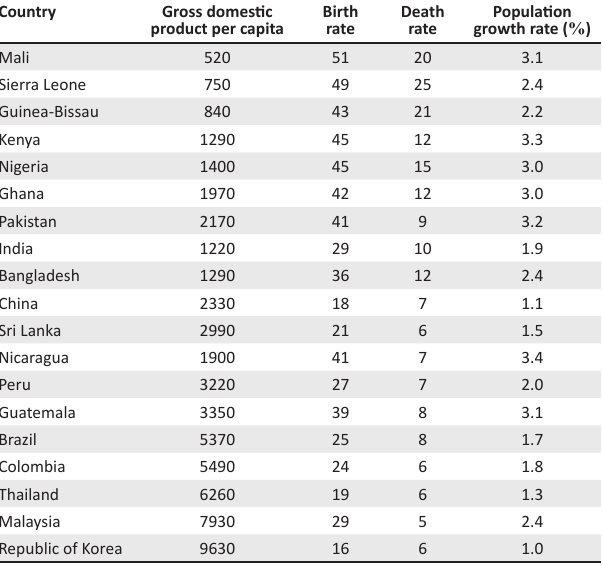
TABLE 1: Gross domestic product per capita, birth, death and population growth rates for selected countries. Country